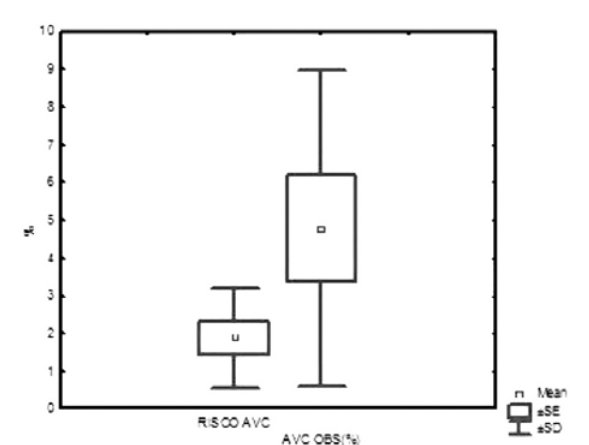
Fig. 4 - Dispersão da diferença entre a incidência de AVC observada e estimada segundo escore da